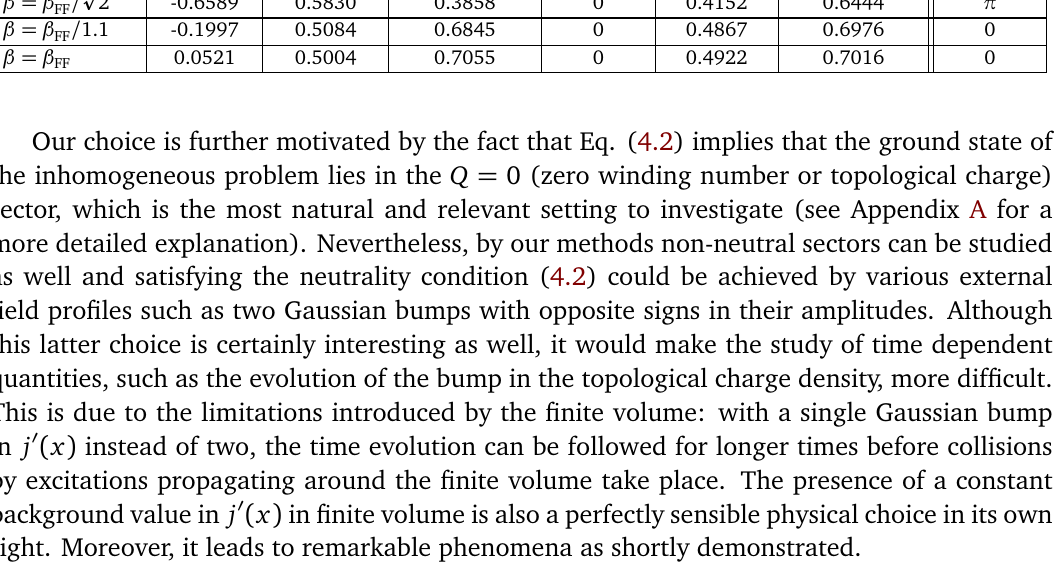
〉 . 〈 denotes the expectation value of operator j 1 O (cid:2) 〈 (cid:3) 〉 is the standard deviation characterising j O